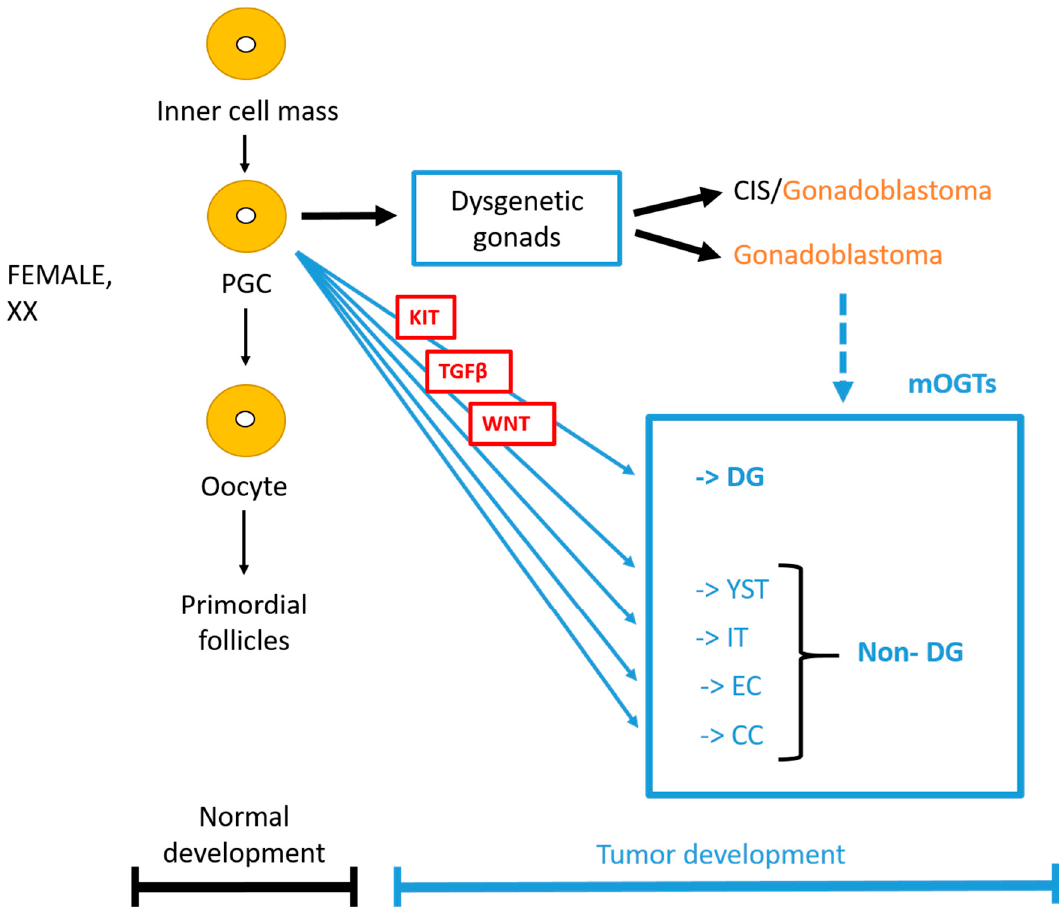
Figure 1. Illustration of germ cell tumor (GCT) development. CC: choriocarcinoma; CIS: carcinoma in situ; DG: dysgerminoma; EC: embryonal carcinoma; IT: immature teratoma; mOGCT: malignant ovarian GCT; PGC: primordial germ cell; YST: yolk sac tumor.